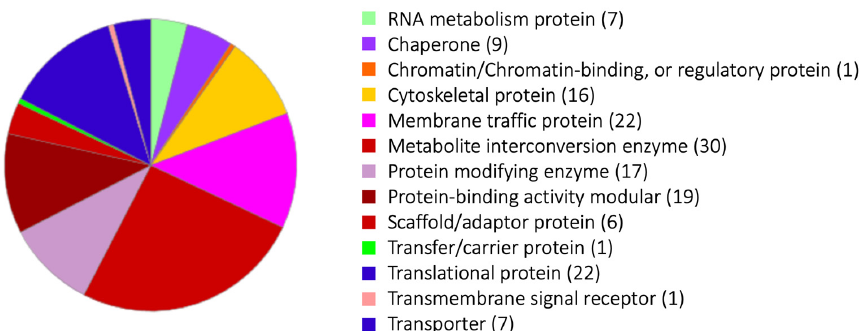
Figure 1. Gene ontology analysis of phagosome proteins isolated by the magnetic bead isolation method. The pie chart of thirteen “protein classes” of the proteins detected from the phagosomes collected by the magnetic bead isolation method. The list of proteins is in Supplemental Table